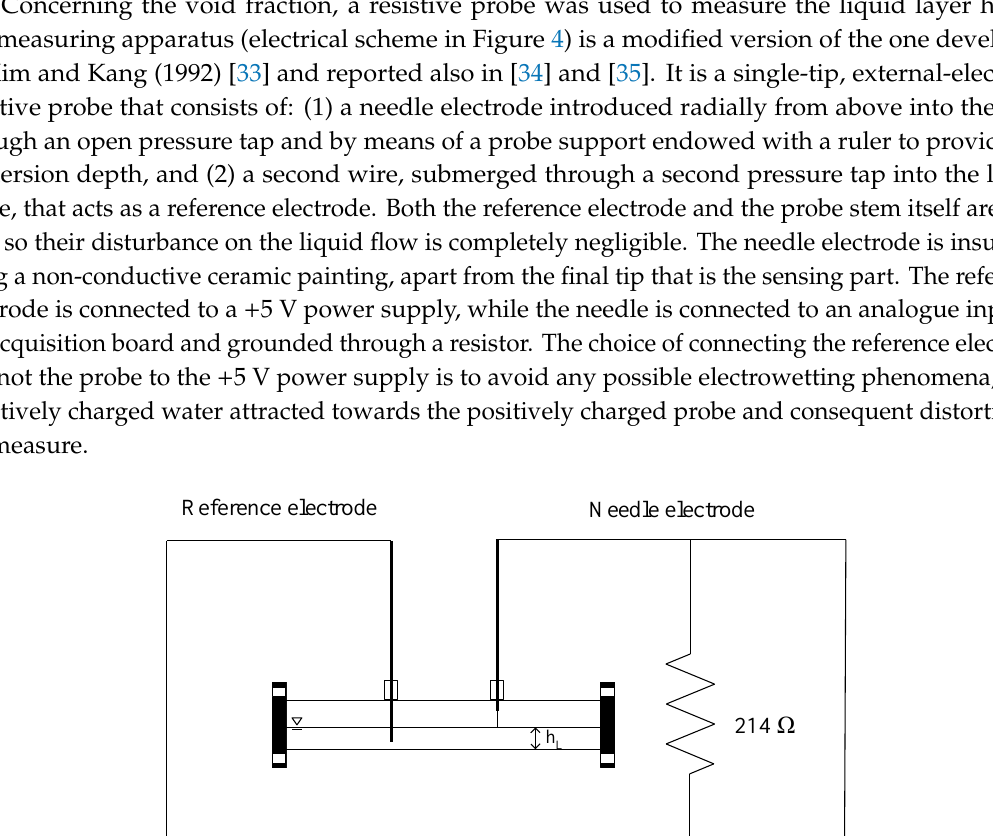
Figure 5. Cross section geometry. The measurements were taken at two different pressure taps and at least five repetitions were done for each one, to assess repeatability. In fact, the outlined method rigorously applies with a smooth interface, which is generally confirmed by visual inspection. In any case, in the presence of weak waviness, the measurement at two different pressure taps enables the determination of the average ℎ 𝐿 . Concerning the accuracy of the liquid height measurement: before the tests, the probe is fully inserted in the duct so that its tip touches the duct bottom and a reference level can be evidenced on the ruler. Then the probe is retracted by the full diameter length and progressively re-inserted until the tip touches the liquid. The tip sinking is visually evaluated. Precision is quite high also when comparing measures performed by different operators and an accuracy of 0.5 mm can be reasonably assumed. Furthermore, an uncertainty analysis on derived quantities was performed, and the results are summarized in Table 4. The reader may refer to Appendix A for an extended discussion. Table 4. Relative uncertainties of the main quantities. Quantity